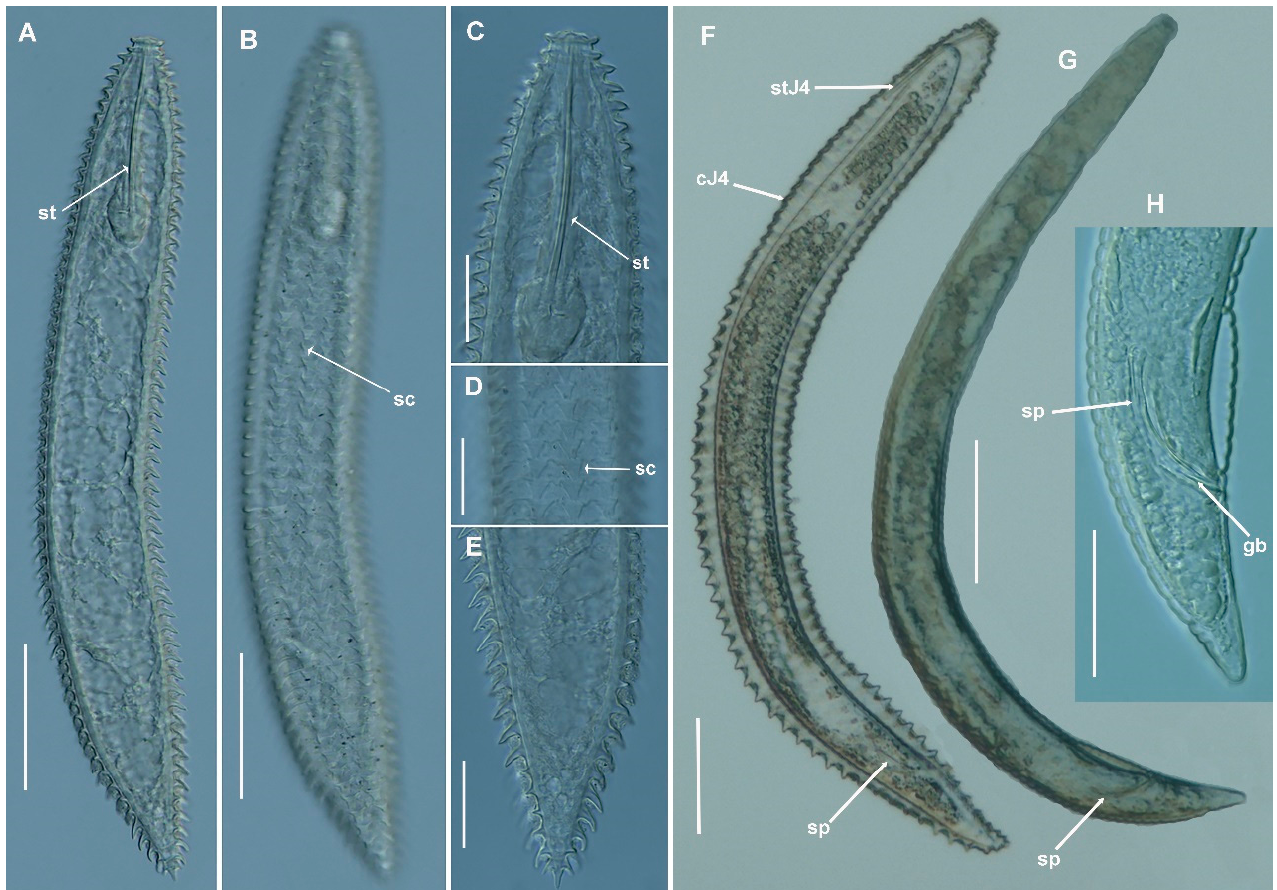
Figure 5. Light micrographs of Criconema paraannuliferum sp. nov. fourth-stage juveniles (J4) and males. ( A , B ), whole fourth-stage juvenile, showing stylet and rows of scales (arrowed); ( C ), J4 anterior region. ( D ), J4 mid-body portion showing rows of scales (arrowed); ( E ), J4 posterior region; ( F ), whole male enveloped by J4 cuticle. ( G ), whole male. ( H ), male tail showing spicules and gubernaculum (arrowed). Abbreviations: cJ4 = cuticle J4; gb = gubernaculum; sc = scales; sp = spicules; st = stylet; stJ4 = stylet of J4. Scale bars: ( A , B ) = 50 µm; ( C – E , H ) = 20 µm; ( F , G ) = 100 µm.